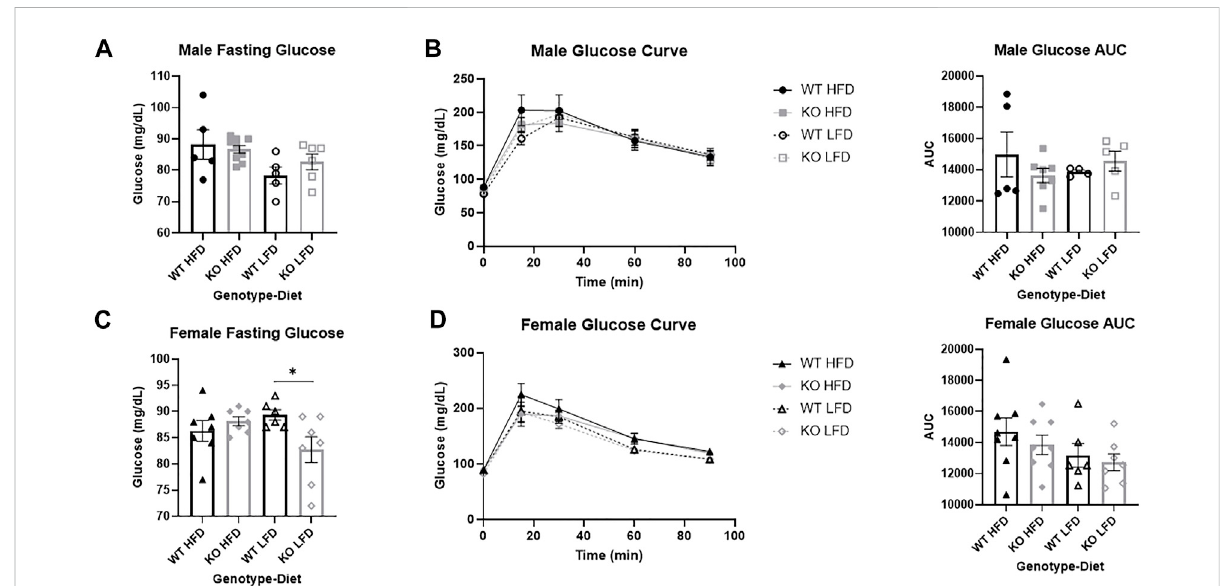
FIGURE 6 Nodifferencesinglucoseresponsebetweenwild-type(WT,black)and Krtcap3 knock-out(KO,gray)rats.After12 weeksondiet,male(top)and female (bottom) rats were fasted for 16 h overnight in preparation for an intraperitoneal glucose tolerance test. (A) There were no differences in fasting glucose between WT males (circle) and KO males (square), neither on a high-fat diet (HFD; fi lled) nor a low-fat diet (LFD; empty). (B) There were also no signi fi cant differences inglucose area-under-the-curve (AUC) betweenWT and KO males, on either dietcondition. (C) There was asigni fi cantgenotype-by-dietinteractionforfemalefastingglucose.WhiletherewasnodifferenceinfastingglucosebetweenWTfemales(triangle) and KO females (diamond) on a HFD, when on aLFD KO females had a lower fasting glucose than WT females. * p < 0.05 for an effect of genotype in the LFD condition. (D) There was no signi fi cant difference in glucose AUC between WT and KO females. Diet effects were seen as reported in the “ Results ”